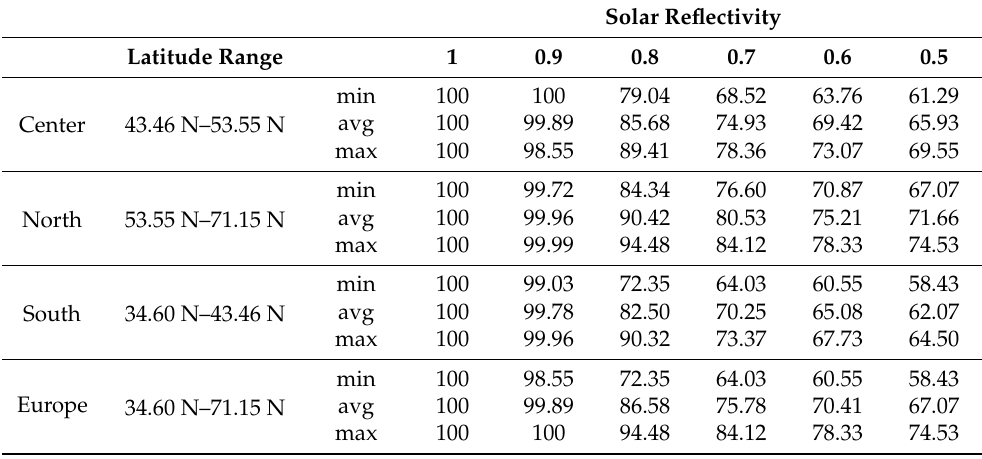
Table 6. Minimum, average and maximum values for each solar reflectivity. RC Activity